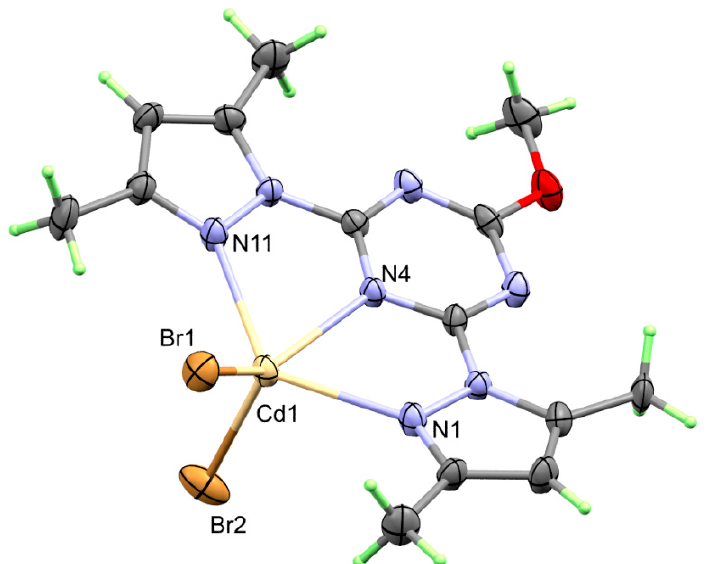
Figure 2. X-ray structure of [Cd( BPMT )Br 2 ]. Table 1. Crystal data and refinement details of [Cd( BPMT )Br 2 ].